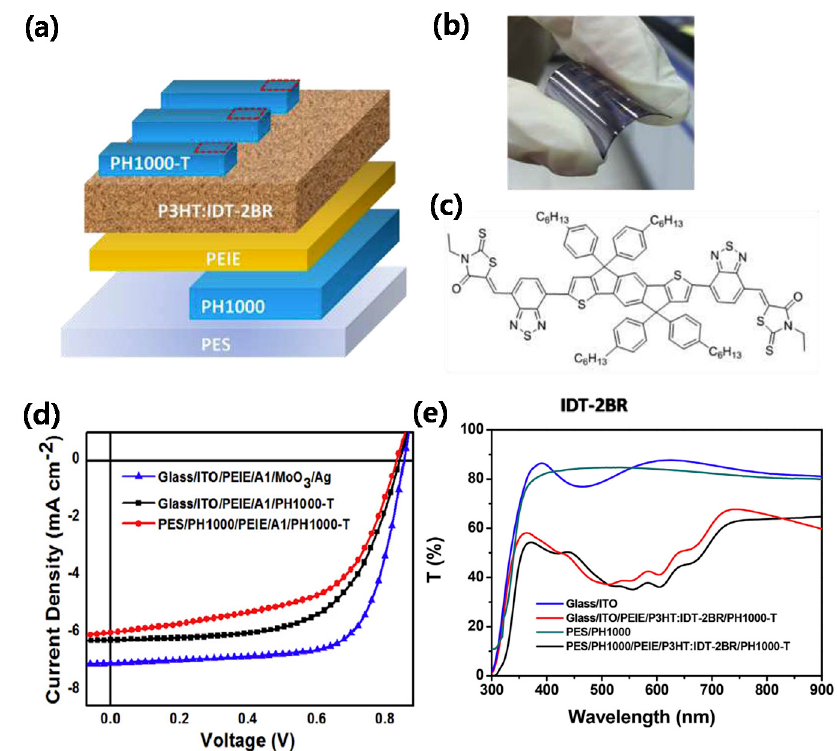
Figure 1. ( a ) Schematic diagram of a typical fullerene-free all-plastic solar cell; ( b ) photo image; ( c ) chemical structure of IDT-2BR; ( d ) J - V curves of all-plastic OSCs based on different acceptors; ( e ) Transmittance spectra of electrodes and corresponding cells. Reprinted with permission from [30].